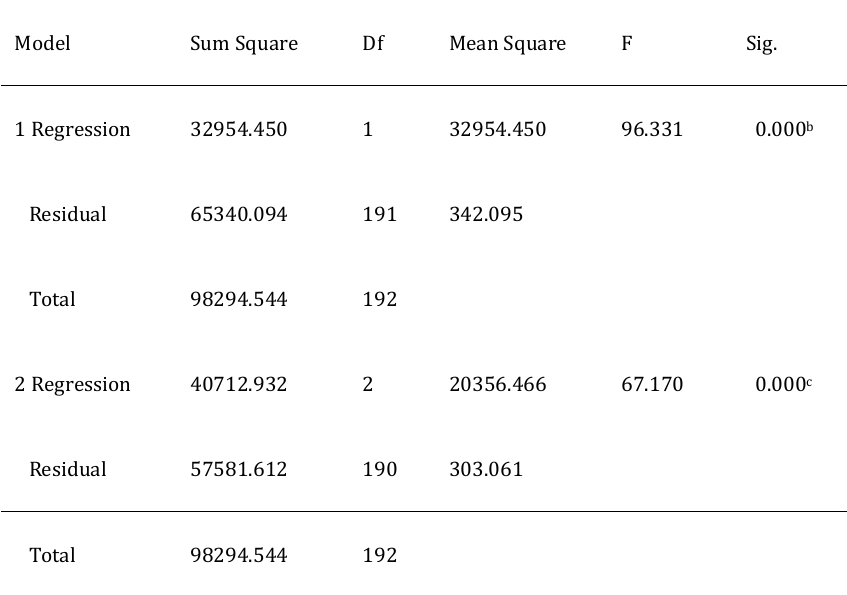
Table 13 The result of the F